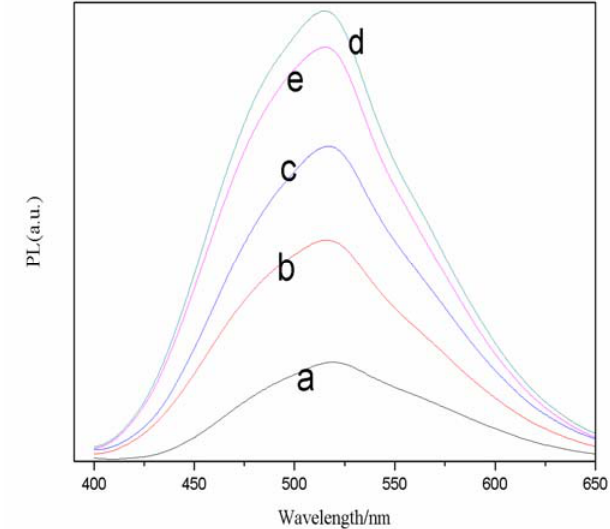
Figure 4. Effects of different pH on normalized FL spectra of TGA-capped CdSe QDs at freezing temperature. Cd/Se/TGA = 3.5:1:2.2. The reaction time was 30 min (a, 8.0; b, 9.0; c, 10.0; d, 10.5; e,